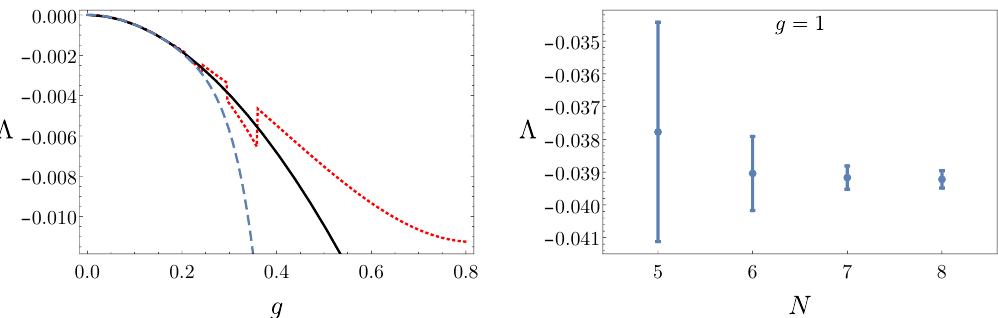
Figure 4 . (Left panel) The vacuum energy (cid:3) as a function of the coupling constant g obtained by ordinary perturbation theory up to the g 8 order (blue dashed line), optimal truncation (red dotted line) and Borel resummation using conformal mapping (black solid line). Notice how optimal truncation gives accurate predictions up to g . 0 : 4, in contrast to blind perturbation theory that breaks down for smaller values of the coupling g . 0 : 2. For g & 0 : 4 the optimal truncation estimate breaks down, since we run out of perturbative terms. Errors are not reported to avoid clutter. (Right panel) Central value and error of (cid:3)( g = 1) as a function of the g N terms kept in the conformal mapping resummation